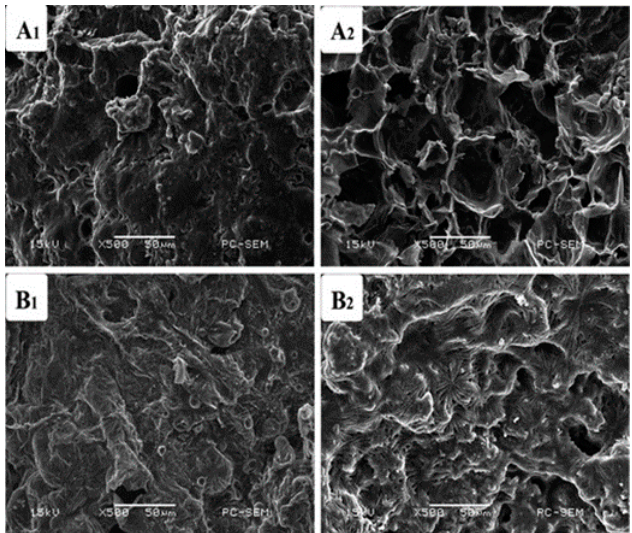
Figure 7. Scanning electron micrographs of the ( A 1 ,B 1 ) upper surface and ( A 2 ,B 2 ) the lower surface of the intumescent char obtained from the samples after cone calorimeter test: ( A ) did not contain P–NS in the PP/IFR and ( B ) contained 2 wt % P–NS in the PP/IFR. Reprinted with permission from ref [66].